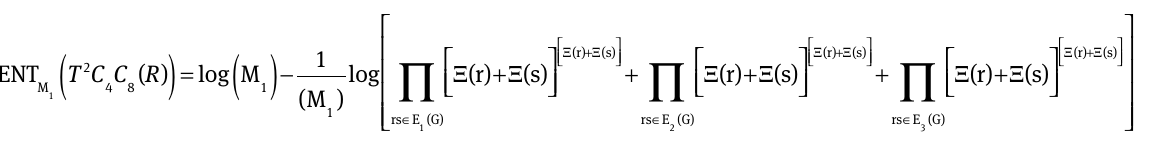
C (R) nanosheet T 2 C 4 8